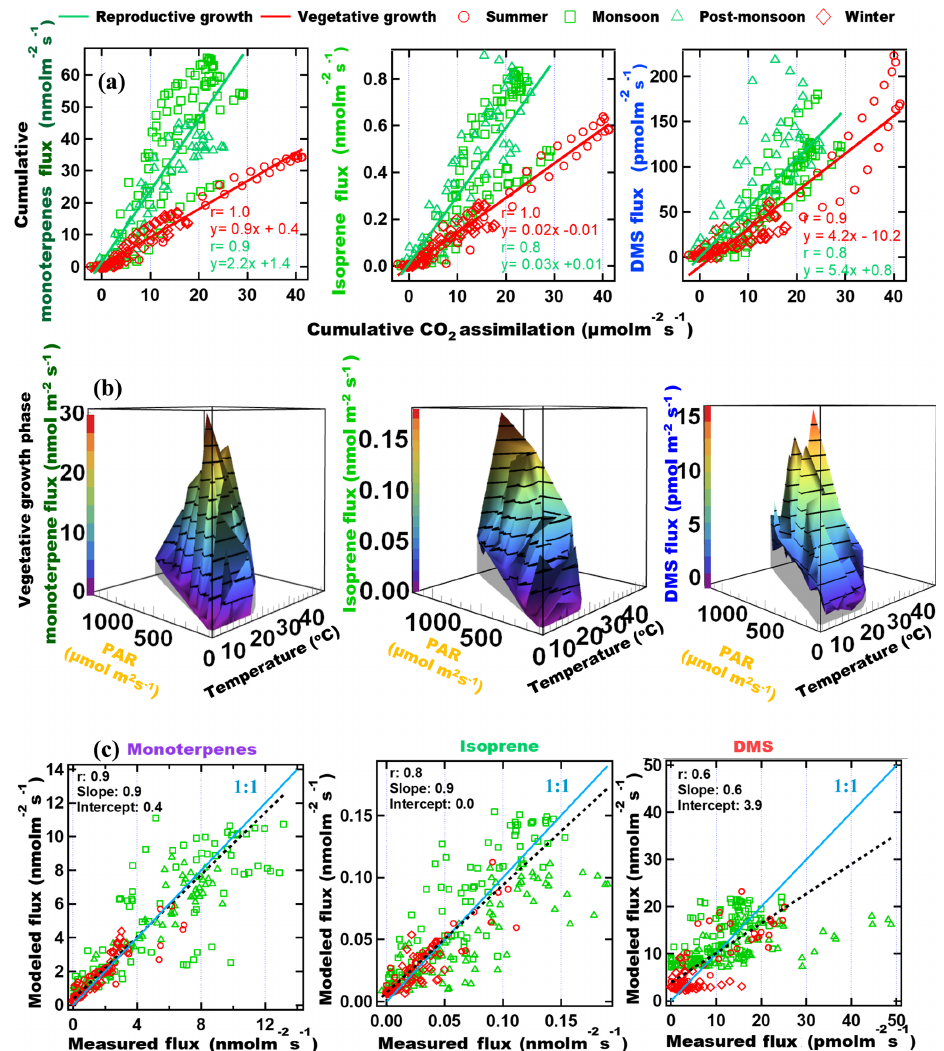
Figure 3. (a) Cumulative BVOC emission fluxes versus cumulative CO 2 assimilation. Cumulative fluxes were calculated for every hour of the day and accumulated from sunrise until that hour. (b) 3-D plot showing the correlation of the emission fluxes with instantaneous chamber temperature and PAR for vegetative growth phase. (c) Modeled versus measured VOC emission fluxes using parameterization presented